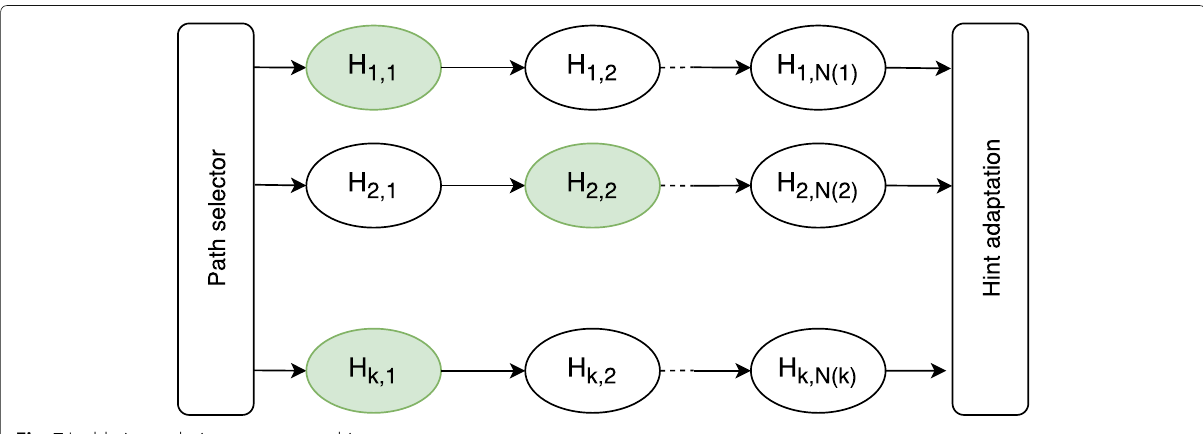
Fig. 7 Laddering technique to generate hints